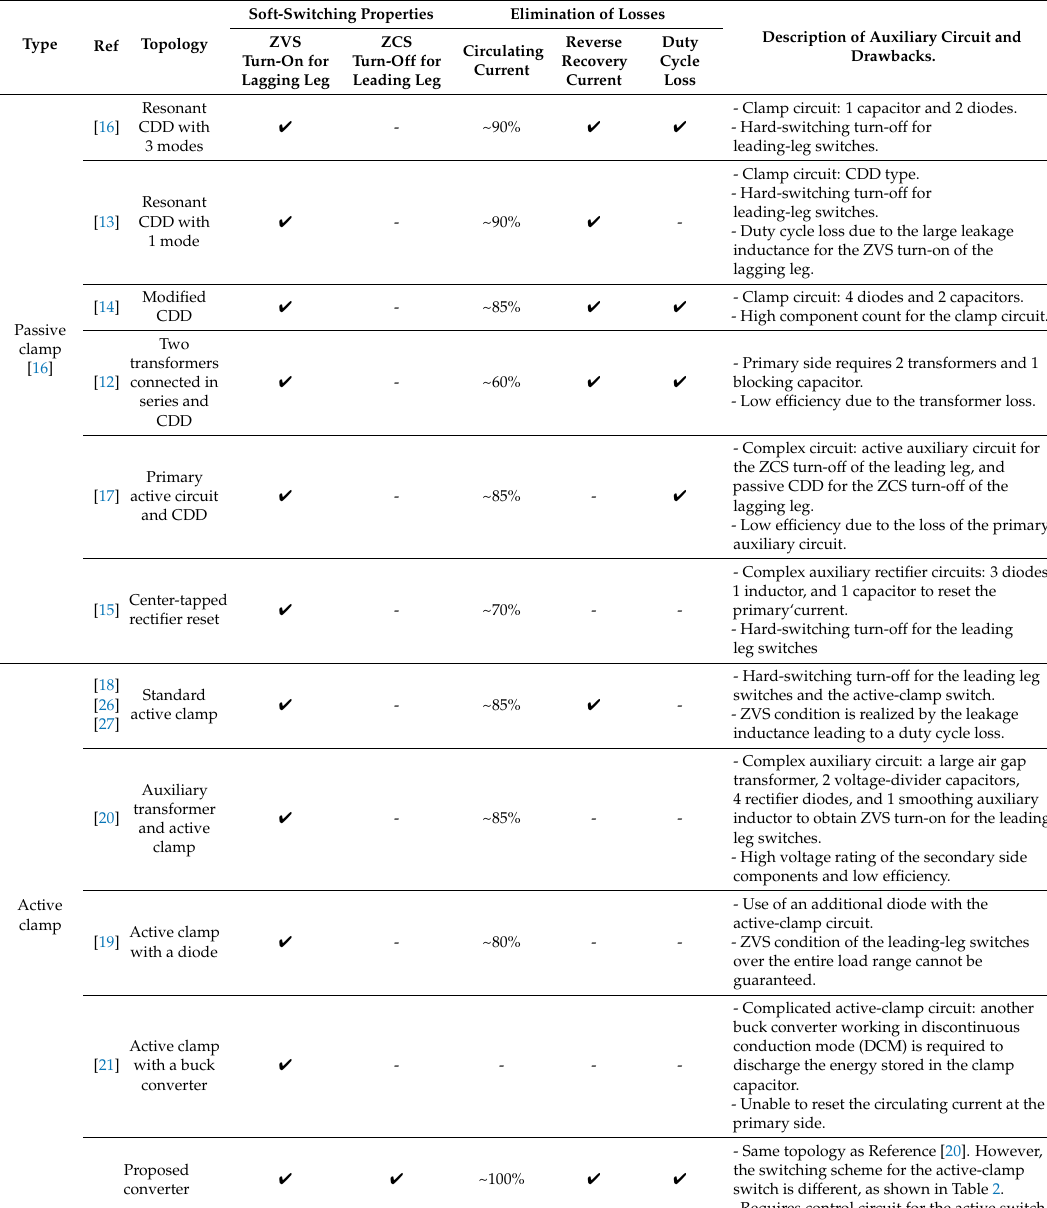
Table 1. Performance comparison of phase-shifted full-bridge (PSFB) converters with various clamp circuits. ZVS—zero-voltage switching; ZCS—zero-current switching; CDD—one capacitor and two